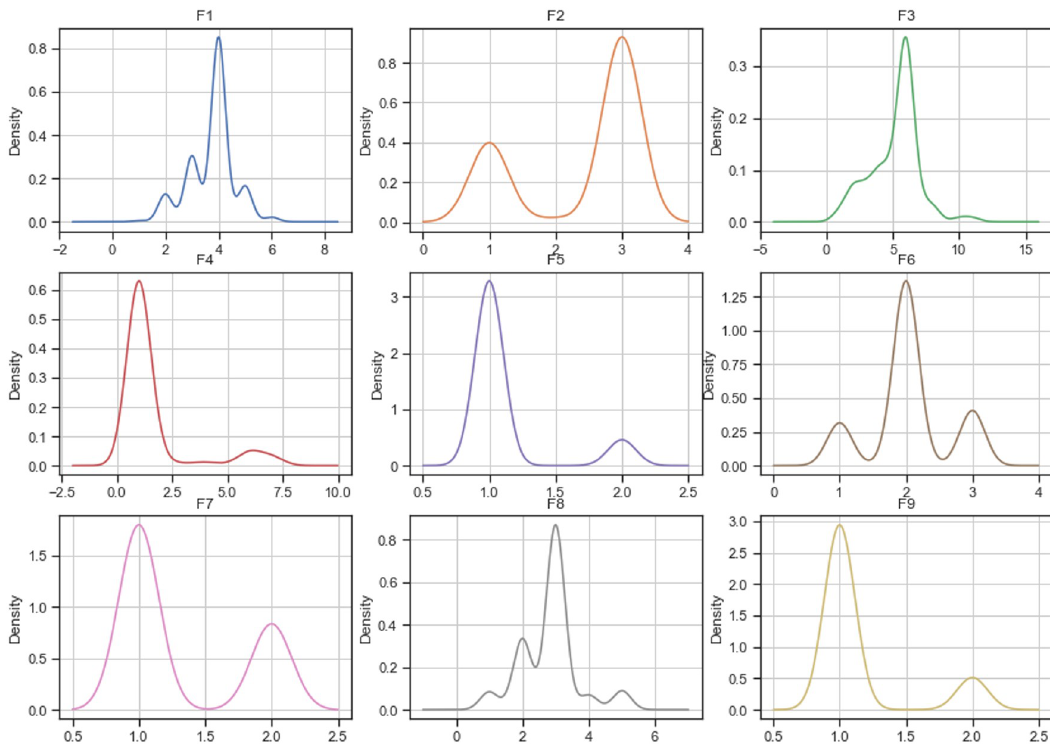
Fig 7. Distribution of breast-cancer dataset imputed by mode.